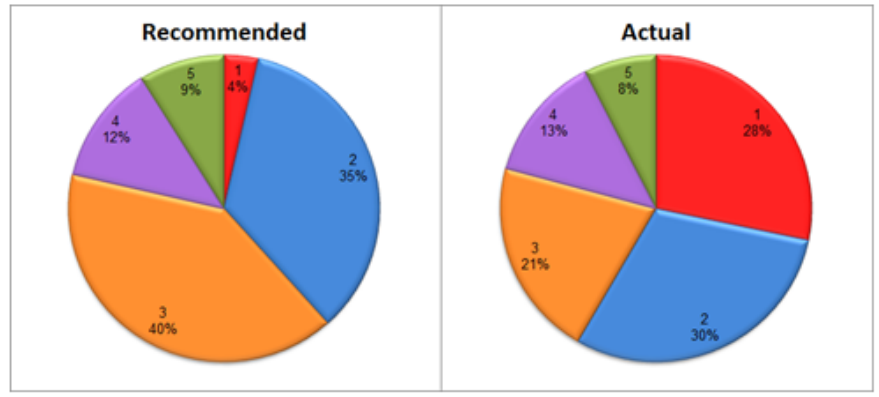
Figure 4. Frequency of recommended and actual number of attempts on an online